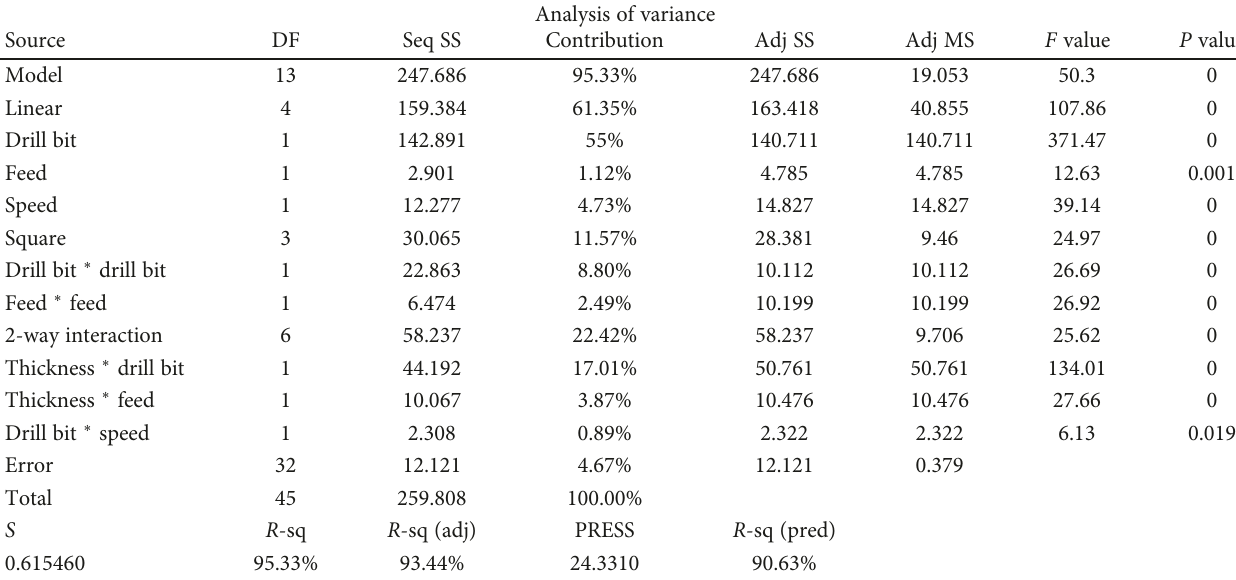
Table 3: ANOVA analysis for surface roughness.